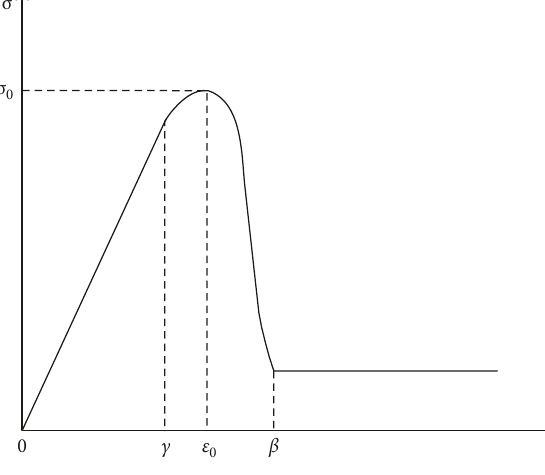
Figure 6: Stress-strain curve of